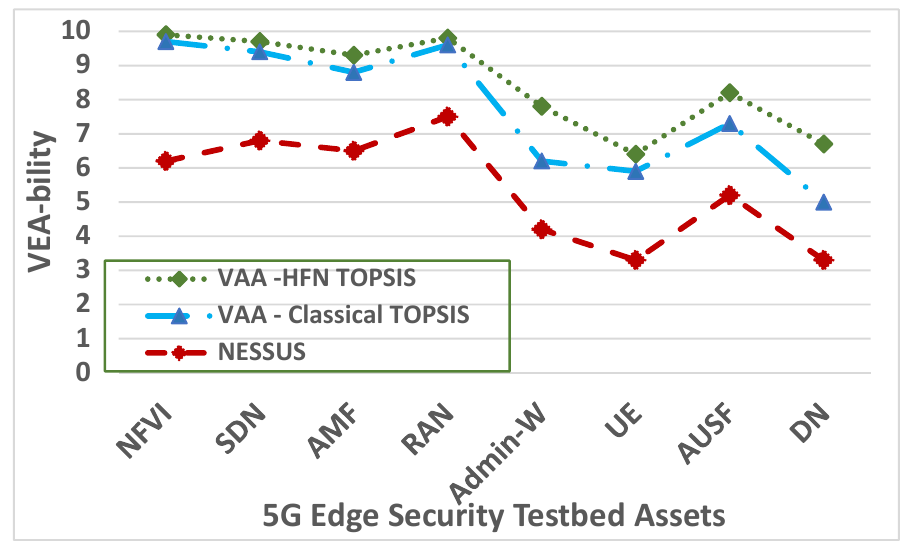
Figure 12. The VEA-bility metric of the VAA and the Nessus.